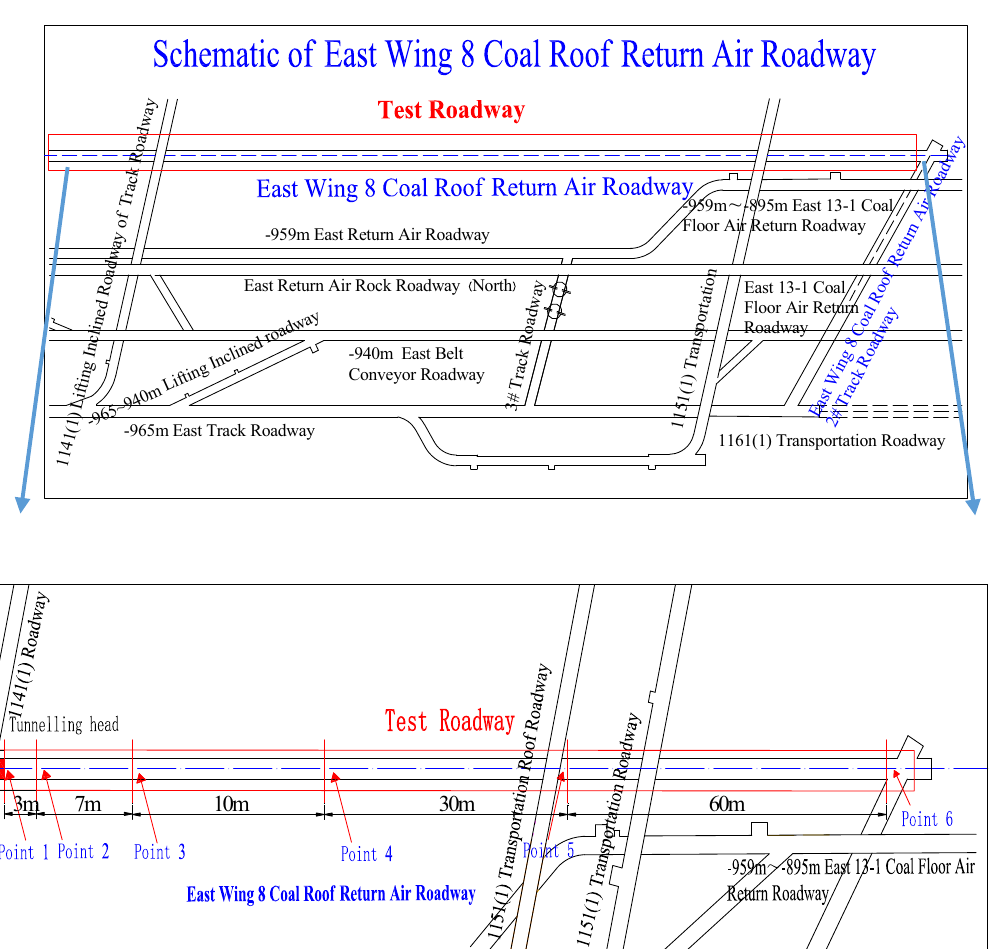
Figure 1: Arrangement of temperature measurement points in the